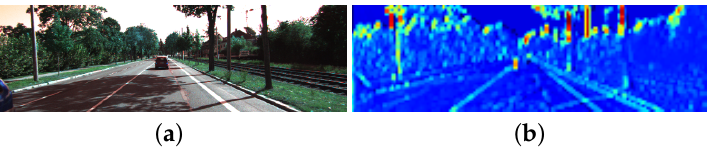
Figure 11. Model—ResNet-18, layer 7, channel 63 weights applied on the test image. ( a ) Test image. ( b ) Channel 63 output on the test image ( a ). Vertical poles and trunks of the trees obtained greater heat-map values denoting higher gradient